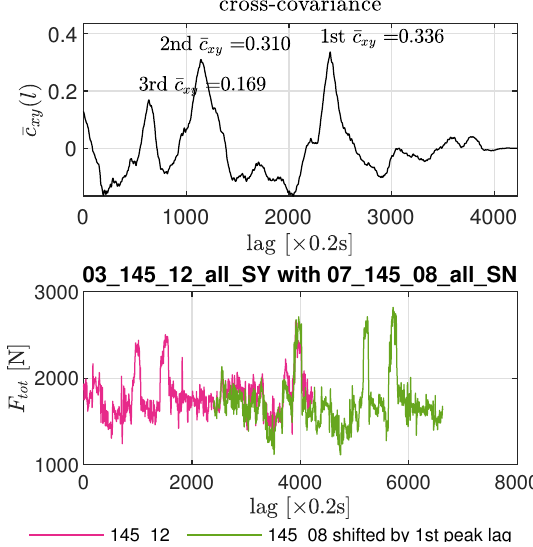
Figure 7: Upper plot normalised cross-correlation of loads on two different rollers indicating 1st to 3rd peak. Bottom plot signal over- laid with shifted signal by 1st peak’s lag.